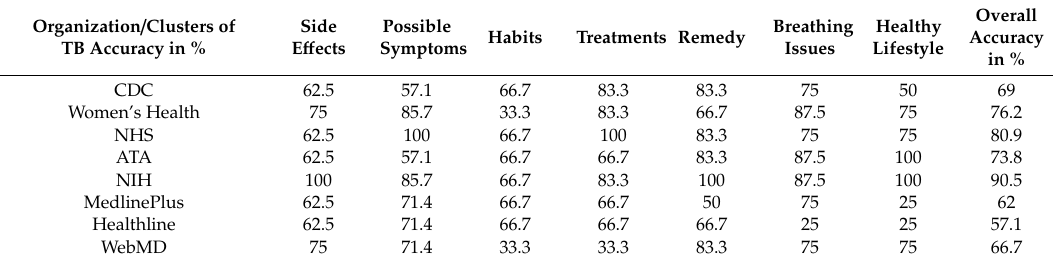
Table 6. Comparison of TB keywords with di ff erent healthcare